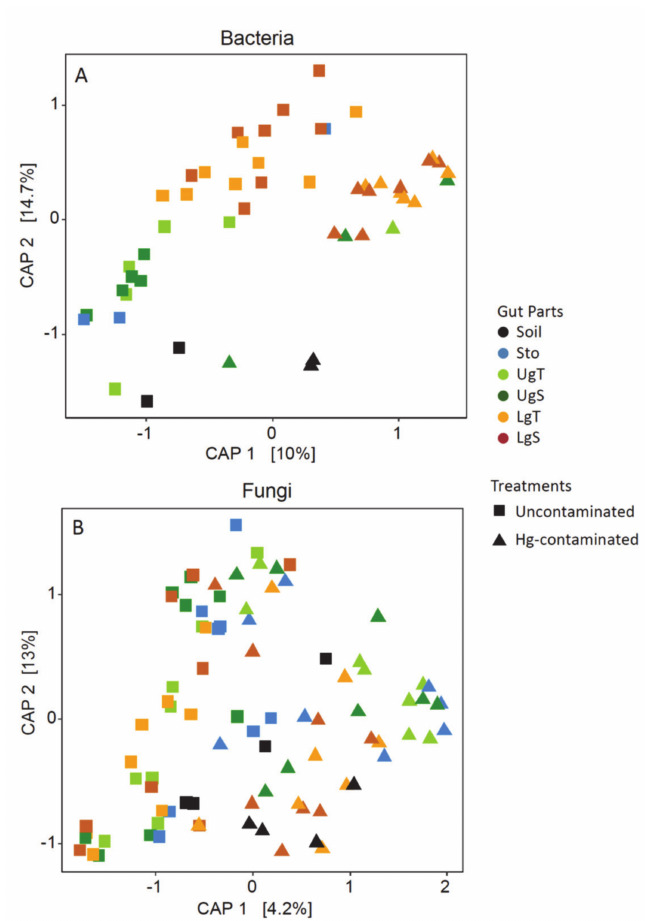
Figure 6. Beta diversity of the bacterial ( A ) and fungal ( B ) communities in experiment 2, presented in a canonical analysis of principal coordinates (CAP) ordination with the Hg treatments and the soil in the pot and earthworm gut parts as constrained factors. Sto = stomach, UgT = upper gut tissue, UgS = upper gut soil, LgT = lower gut tissue, LgS = lower gut